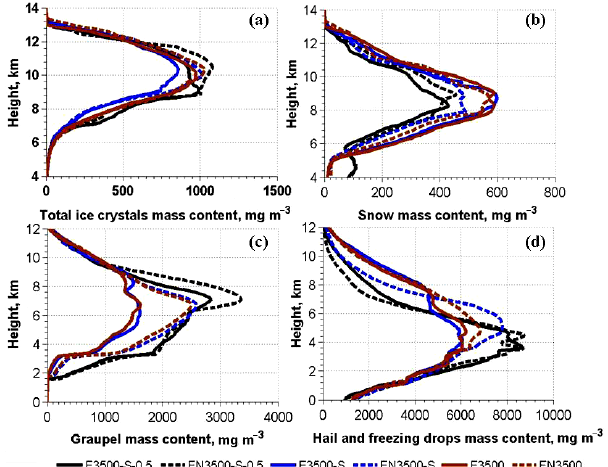
Figure 6. Vertical profiles of the maximum values of mass content: (a) total ice crystals, (b) snow, (c) graupel, and (d) total hail and freezing drops in simulations with high CCN concentration. The profiles are obtained by averaging over the time period of 4860– 5460s.